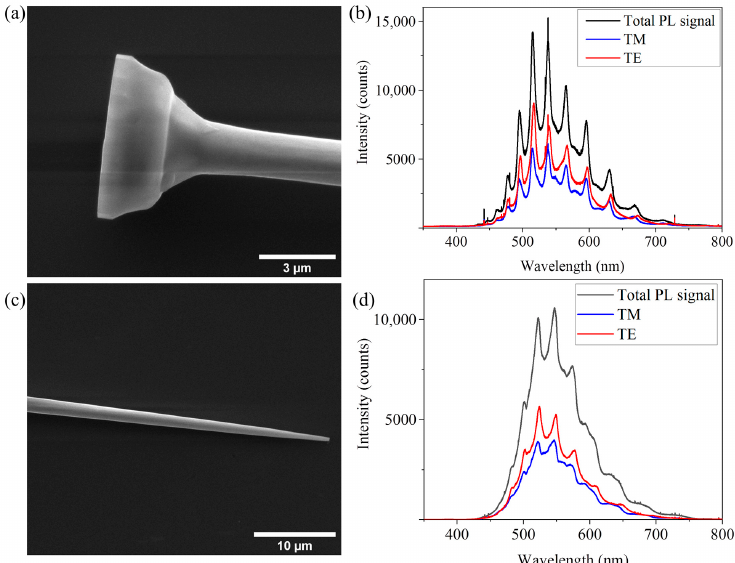
8 Figure 8. SEM micrograph and µ -PL spectra for all polarization modes for the hexagonal head in region (i) ( a , b ) and the tip of the nail in region (iv) ( c , d ). The resonance modes were broader than other regions due to the rapid changes in the cross-section length, blurring the